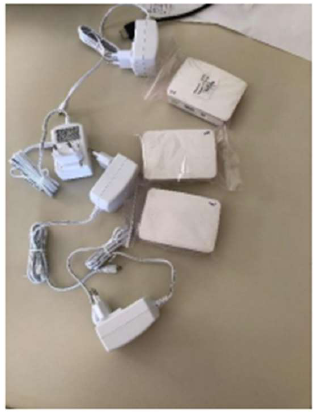
Figure 6. The Raspberry Pi devices.